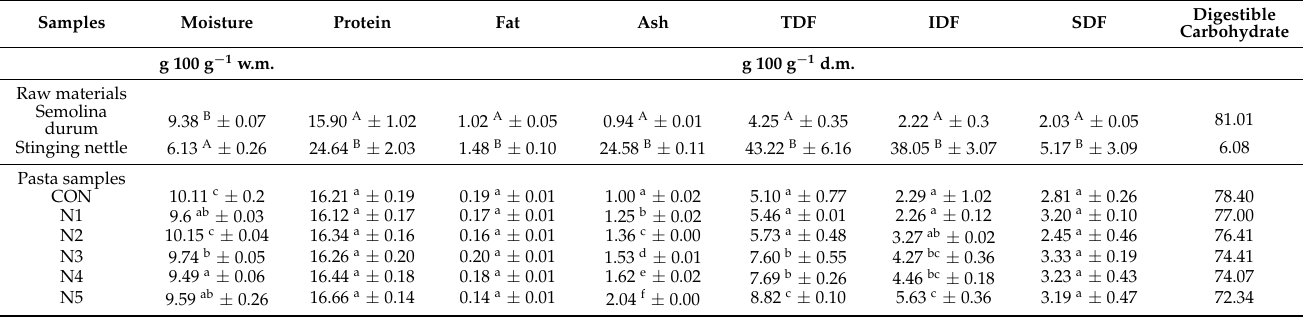
Table 2. Basic chemical composition of raw material and pasta